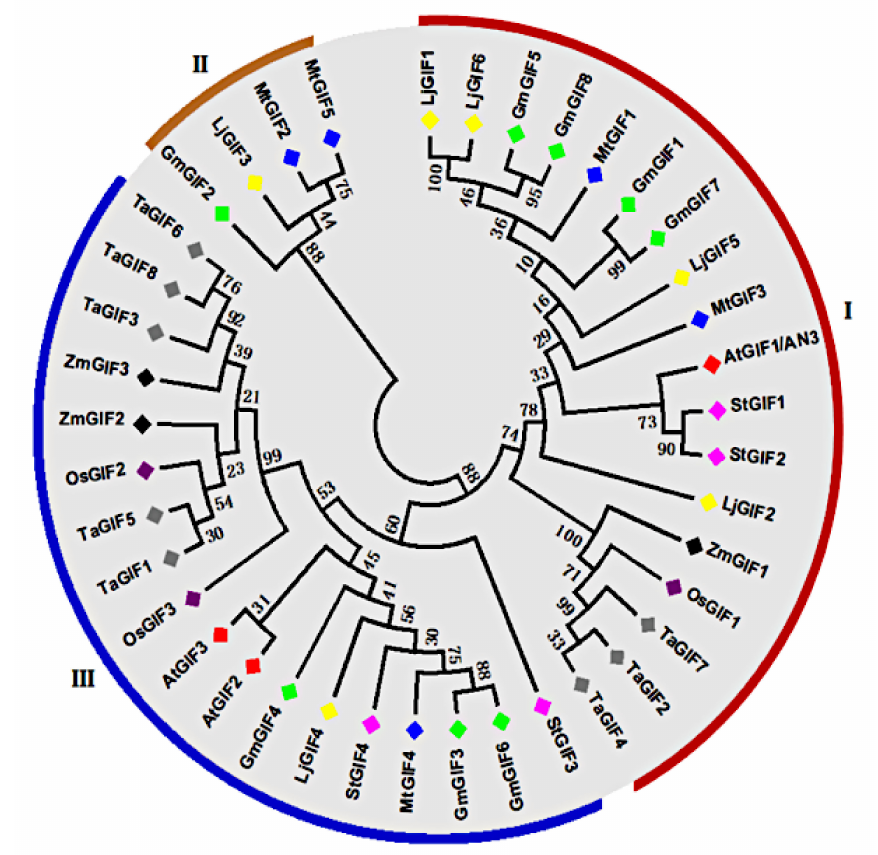
Figure 1. Phylogenetic tree of A. thaliana , G. max , M. truncatula , O. sativa , T. aestivum, L. japonicas , S. toberosum , and Zea mays GIF proteins. A neighbor-joining (NJ) phylogenetic tree was generated by MEGA7. The bootstrap values from 1000 replications are provided at each